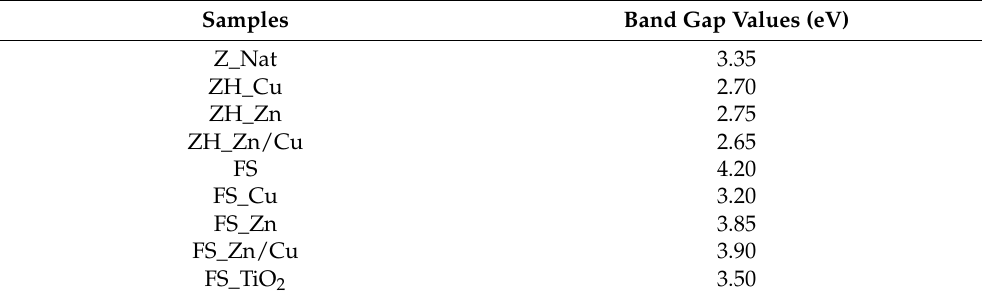
Table 2. Band gap energies of prepared photo-catalysts, including their respective supports. Results were obtained by UV-Vis DRS